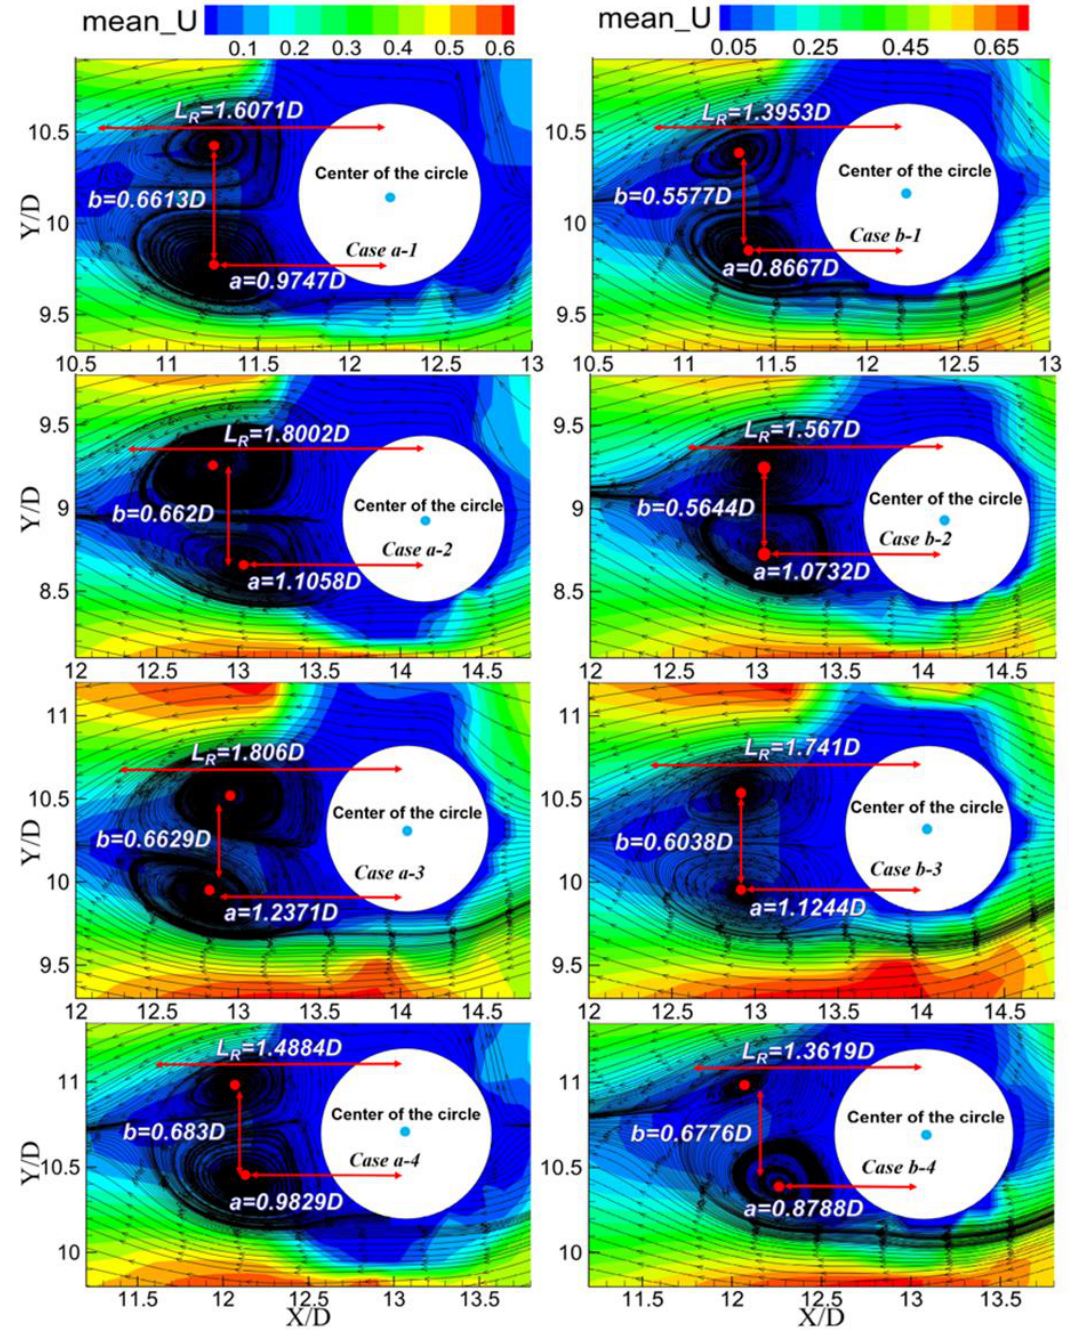
Figure 12. Time-averaged streamlines and mean streamwise velocity contours of the experiment.